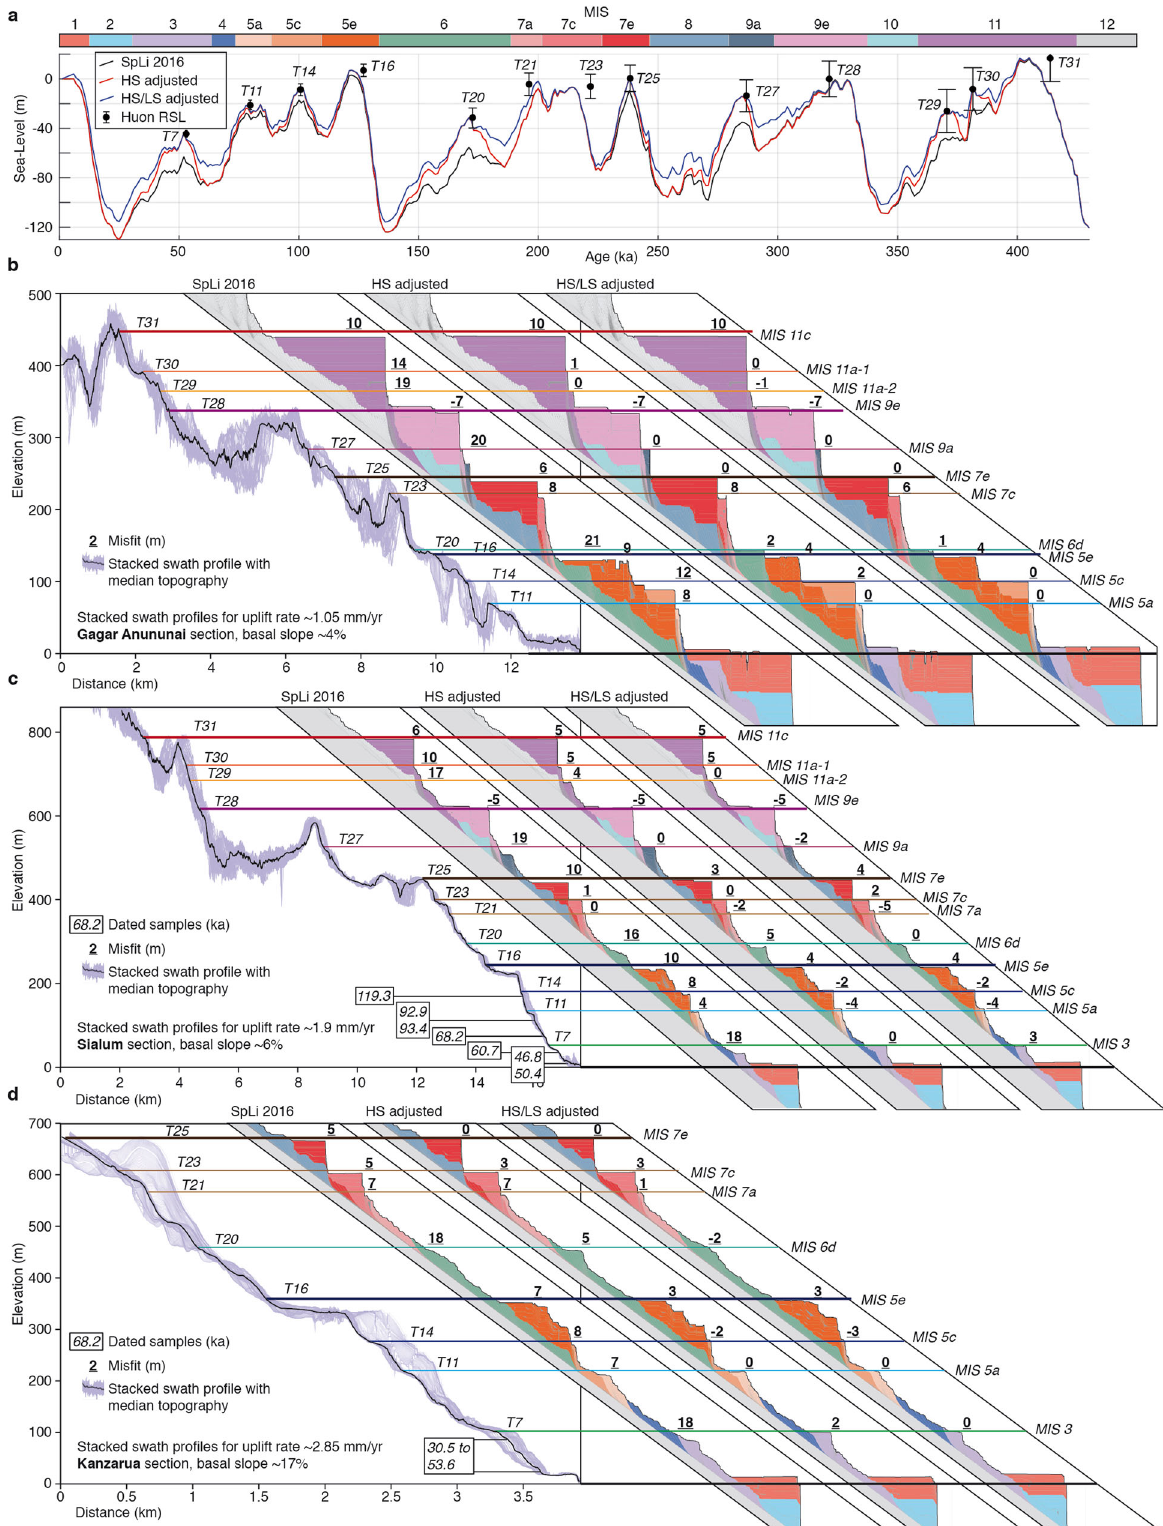
multiple times, as observed in the data with multiple clusters of ages between ∼ 90 ka and ∼ 140 ka for the same terrace (Supple- mentary Table 1; 19,20,45 ). Considering the mis fi ts between modeled and observed terrace elevations, curves with adjusted highstands better fi t the observed terrace morphology, particularly for interstadial terraces